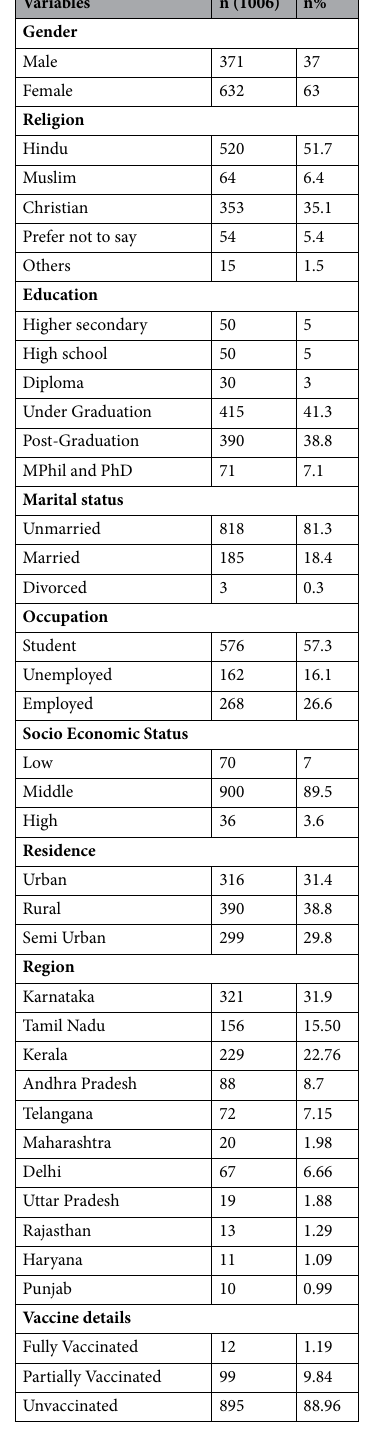
Table 1. Distribution of socio-demographic characteristics of the